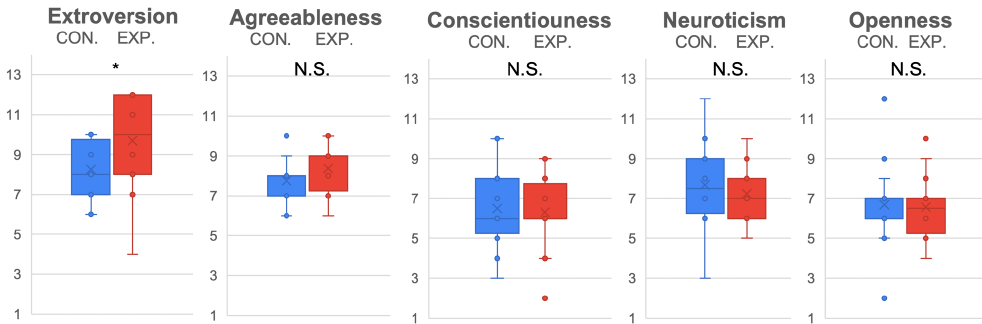
Figure 6. Emotion expression and evaluation of ERICA evaluated by male subjects. * indicates the found significant difference, while N.S. indicates there is no significant difference.